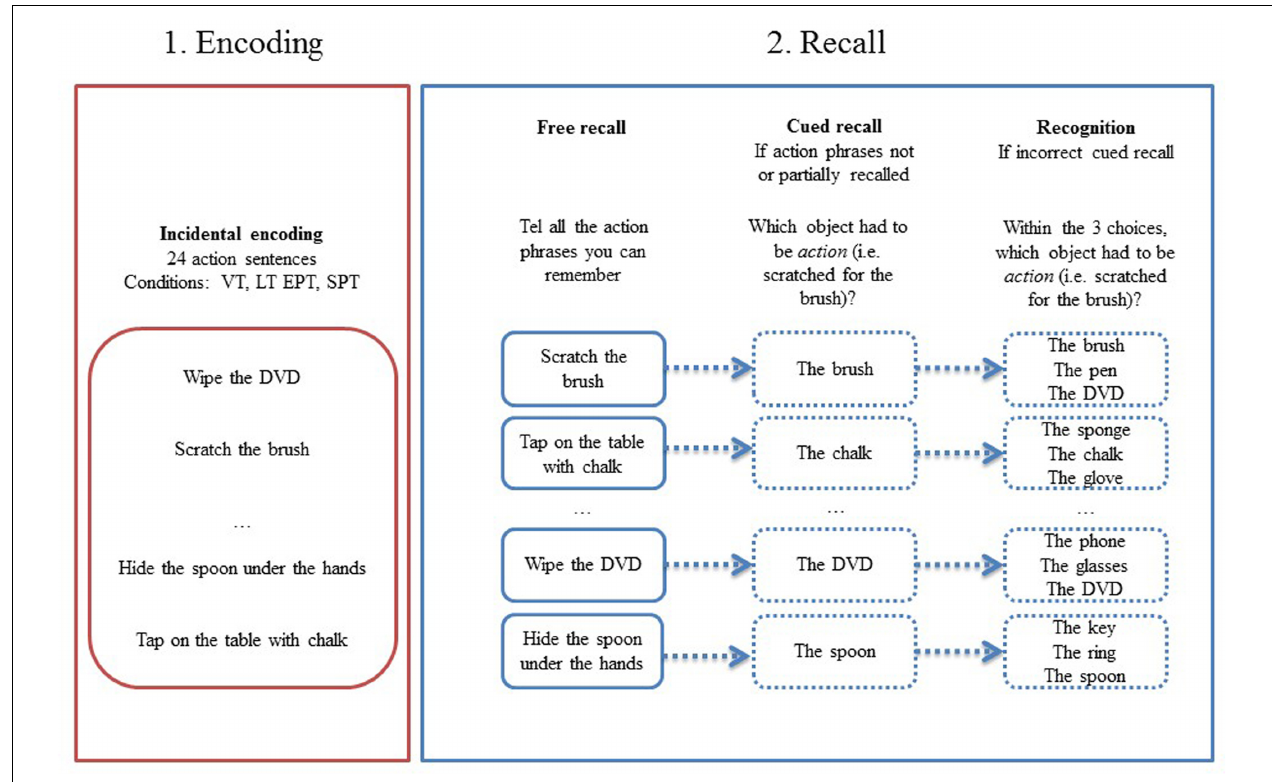
FIGURE 1 | Design for the enactment effect task. After encoding 24 actions, participants have to retrieve actions in free and cued recall. There was a recognition for items incorrectly recalled in the free or cued recall. VT, Verbal Task; LT, Listening Task; EPT, Experimenter-Performed Task; SPT, Self-Performed Task.